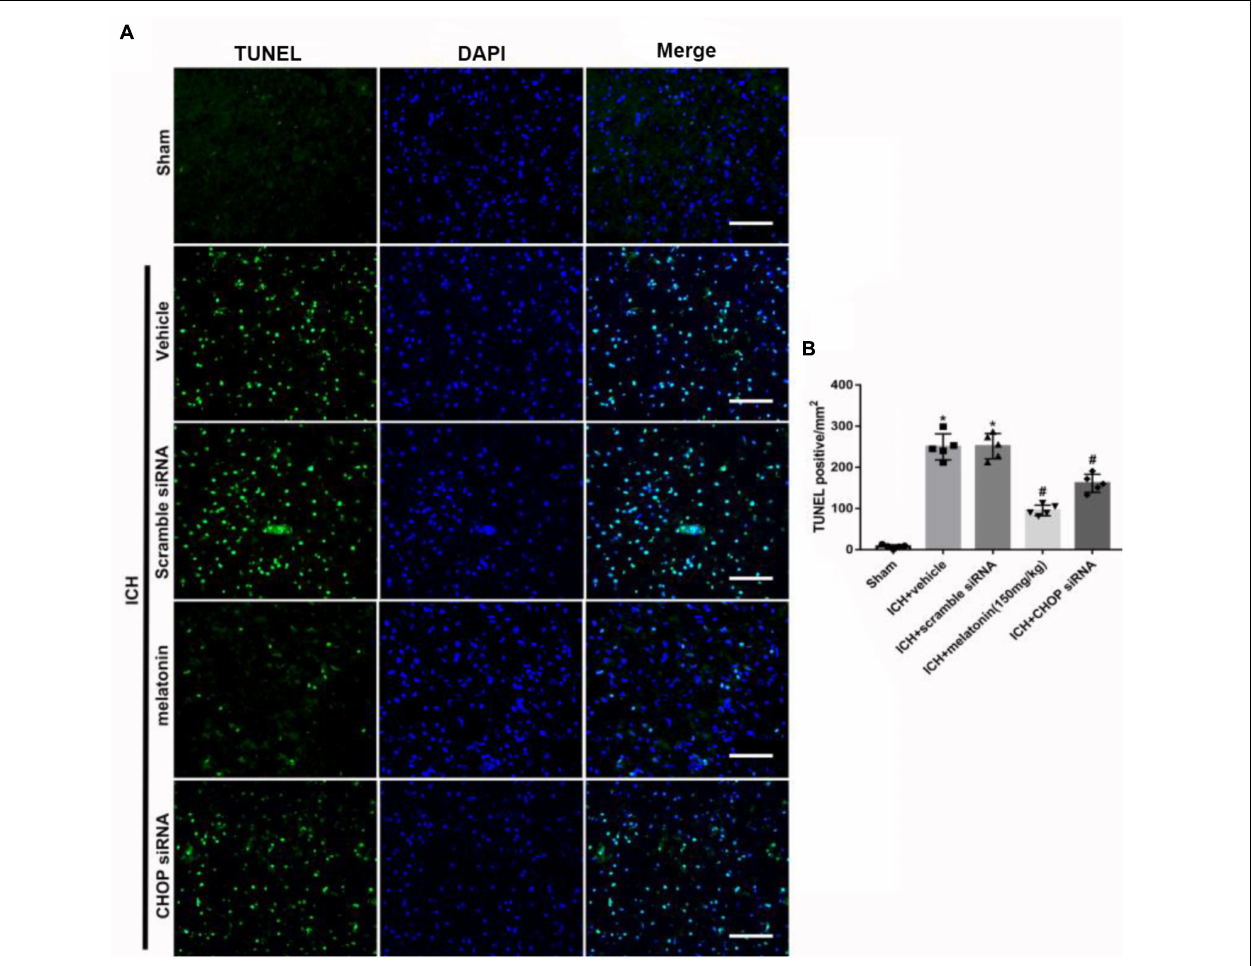
FIGURE 6 | The administration of melatonin significantly decreased the number of TUNEL and DAPI double-stained cells in the perihematomal region 24 h after ICH. (A) Representative microphotographs showed the co-localization of DAPI (blue) with TUNEL (green)-positive cells in injured brain hemisphere at 24 h after ICH; (B) Quantitative analysis of TUNEL-positive cells showed that melatonin decreased the number of apoptotic cells after ICH. Scale bar = 100 µ m. ∗ p < 0.05 vs. sham, # p < 0.05 vs. ICH +